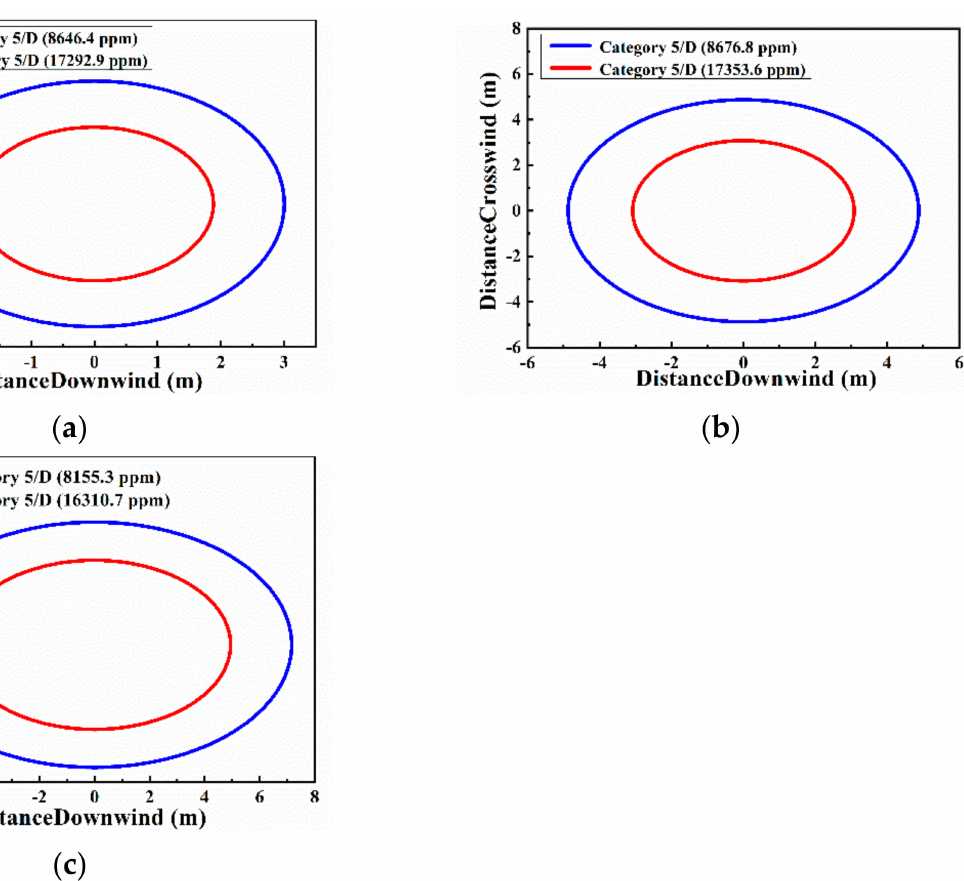
Figure 13. The simulated range of flash fire under different leakage flowrates of ( a ) 120.4 kg/h, ( b ) 584.8 kg/h, and ( c ) 705.2